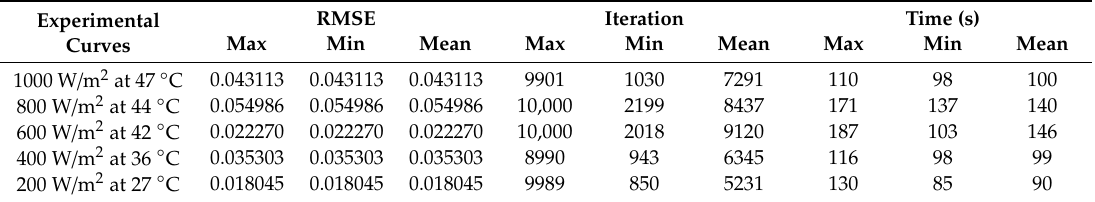
Table 14. Statistical results for the single-diode JKM330P-72, 310 W polycrystalline PV module. Experimental